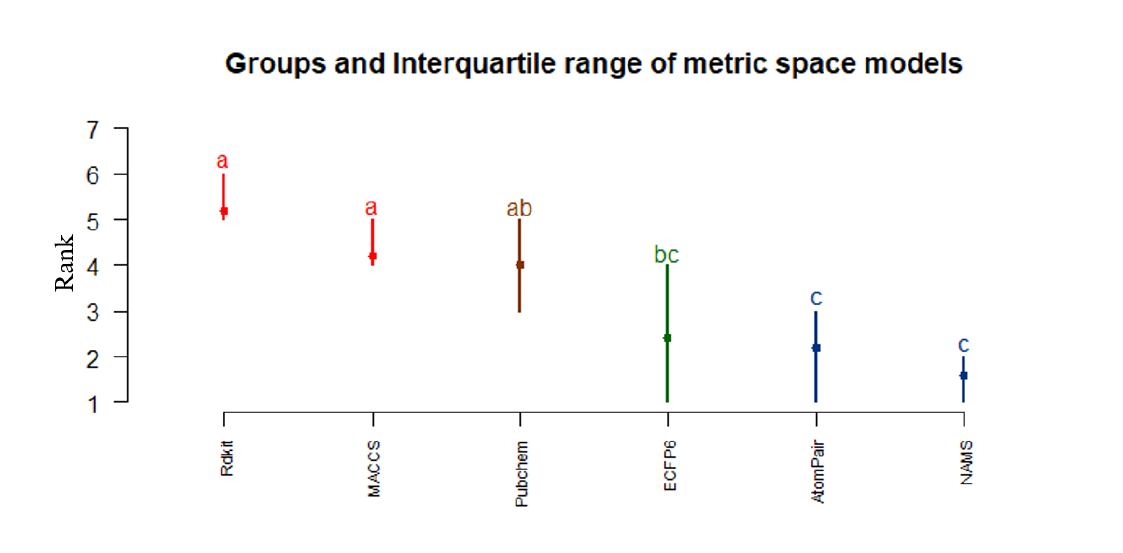
Figure 6. Overall performance of similarity representation using PCA on metric space-based QSAR modeling